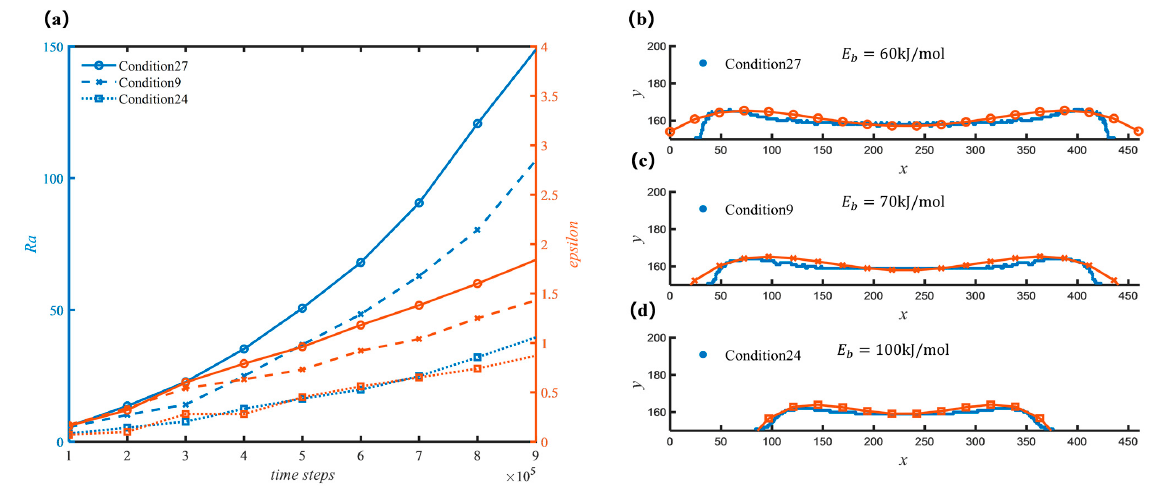
Figure 9. Morphology of sediments with different Growth barrier. ( a ) Curves of roughness and overall trend with different working conditions; ( b ) Sediment profile and fit line for condition 27 at 500,000 time steps; ( c ) Sediment profile and fit line for condition 9 at 500,000 time steps; ( d ) Sediment profile and fit line for condition 24 at 500,000 time